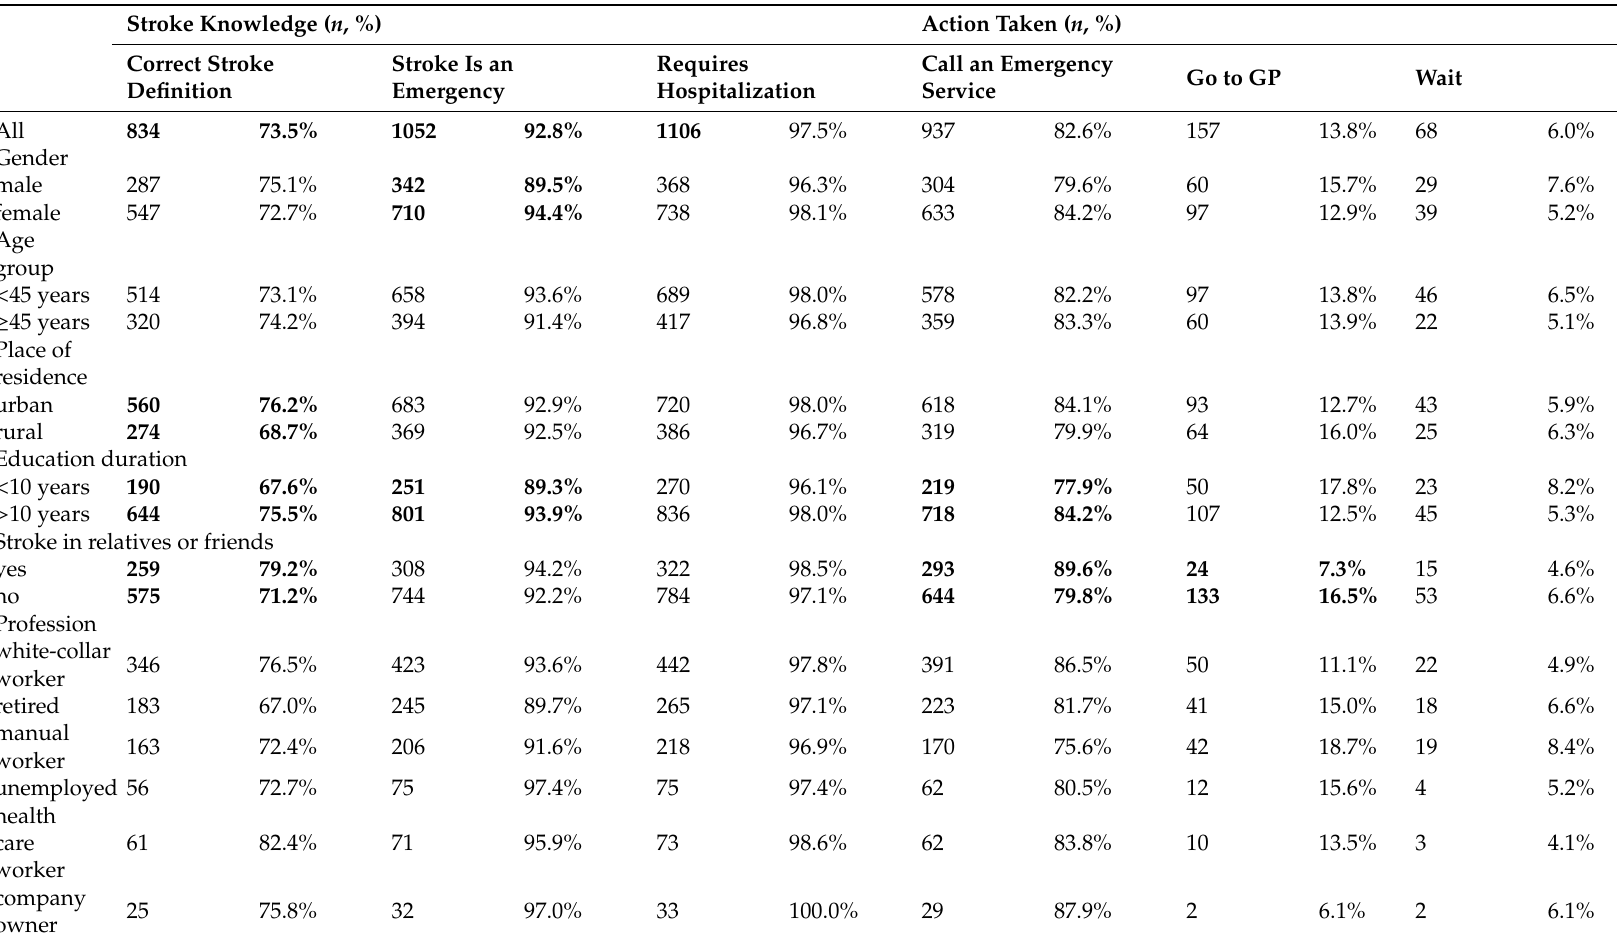
Table 2. Correct stroke definition and proper actions required in case of stroke reported by participants grouped by gender, age group, place of residence, education level, and